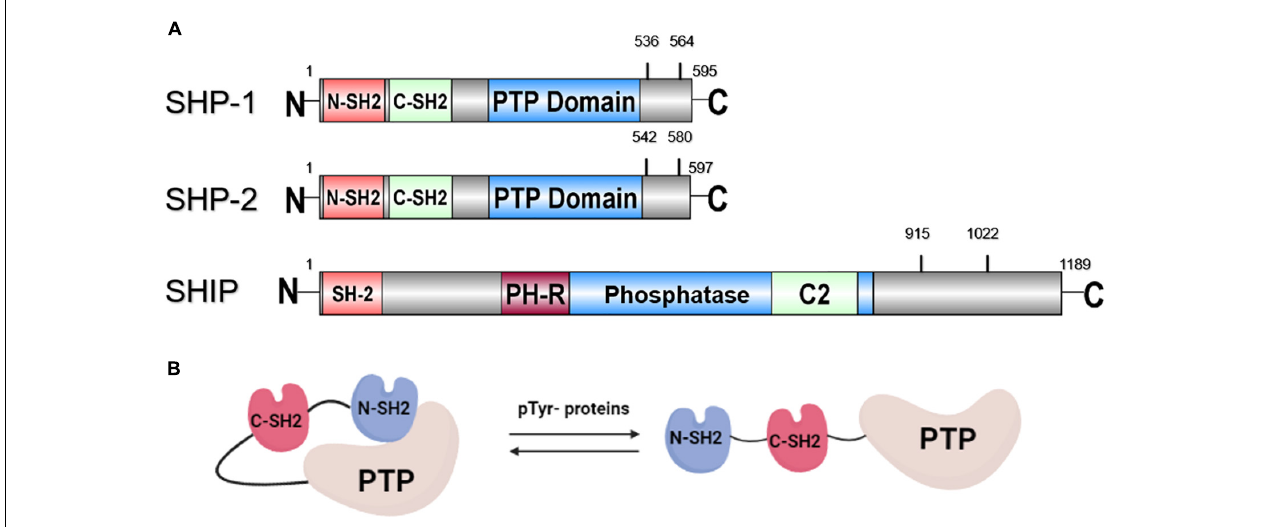
FIGURE 1 | (A) Schematic representation of the structure of SHP-1, SHP-2, and SHIP with tyrosine phosphorylation sites. (B) Structure of SHP protein in auto-inhibited and activated conformation.